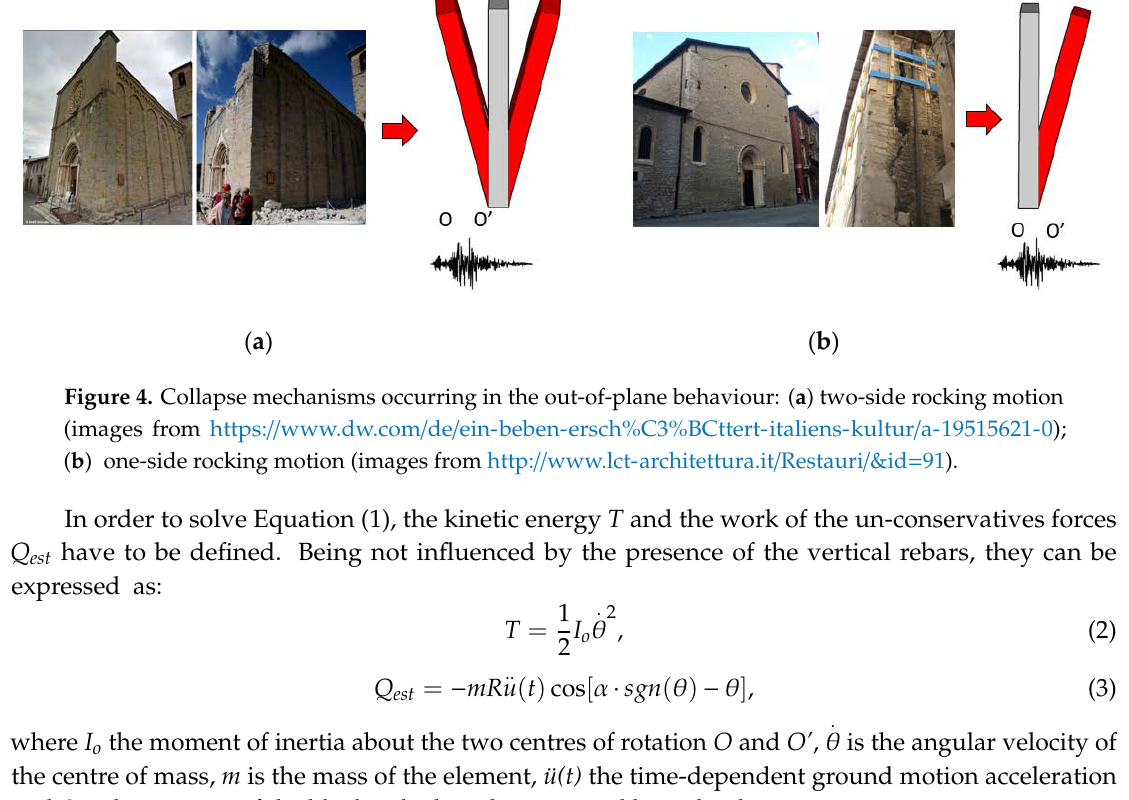
Figure 3. Model of the wall: ( a ) three-dimensional view; ( b ) model geometry.